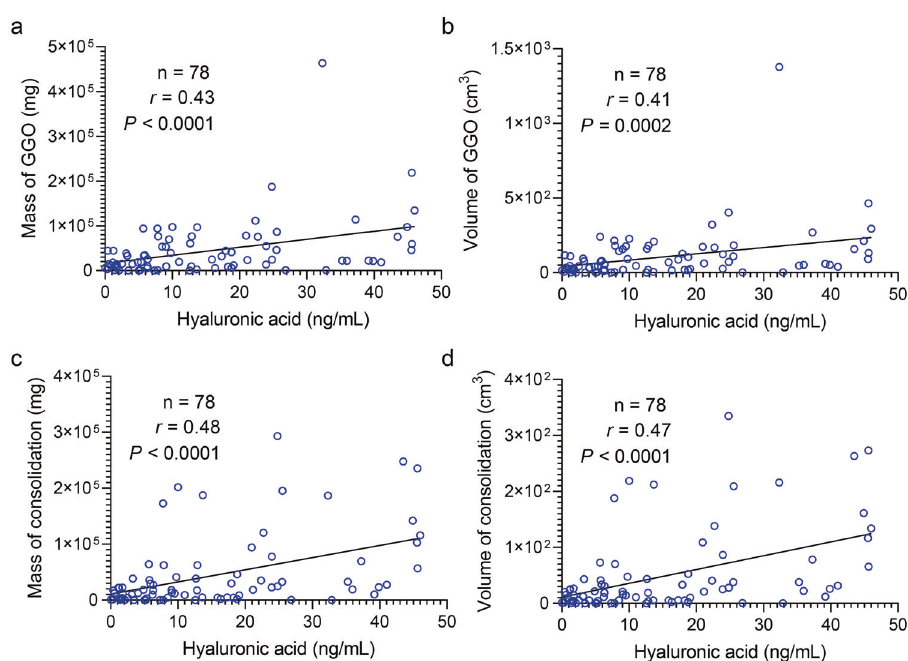
Fig. 3 Correlation between hyaluronan and pulmonary lesions in COVID-19 patients with a low level of hyaluronan (HA < 48.43 ng/mL). a , b Scatter plot showing relation on the mass ( a ) and volume ( b ) of GGO against hyaluronic acid. c , d Scatter plot showing relation on the mass ( c ) and volume ( d ) of the consolidation region against hyaluronic acid. Mass and volume of pulmonary lesions were calculated via the automatic lung segmentation technology of AI based on CT images of severe COVID-19 patients. GGO was de fi ned a range from − 750 HU to − 300 HU, and the consolidation region was de fi ned from − 300 HU to 50 HU. Two-tailed Spearman ’ s correlation analysis was performed to identify the relation of pulmonary lesions against hyaluronic acid